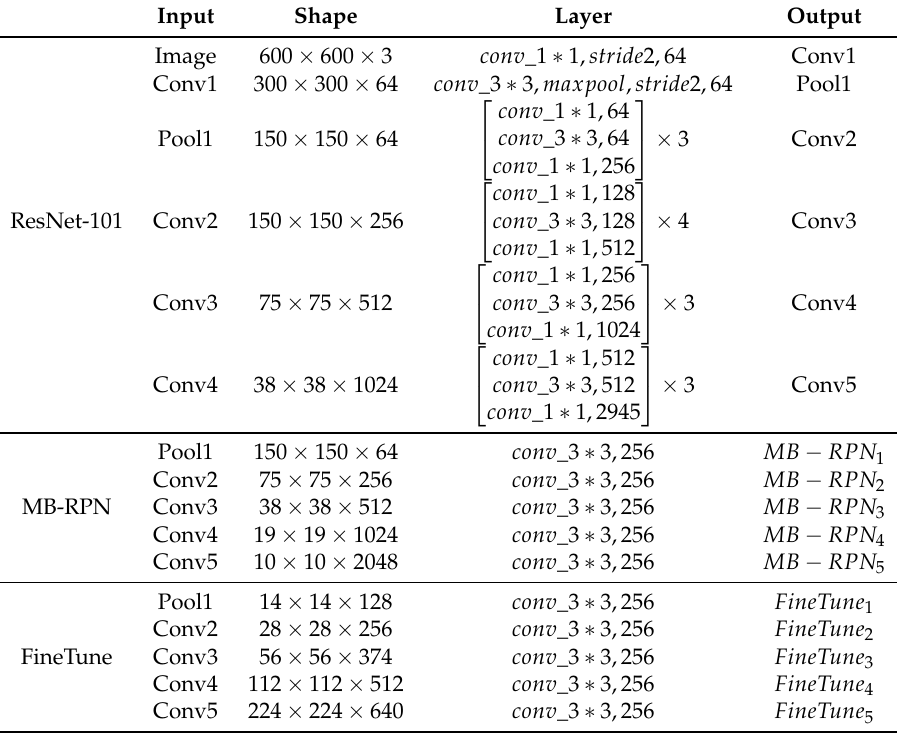
Table 1. Details of